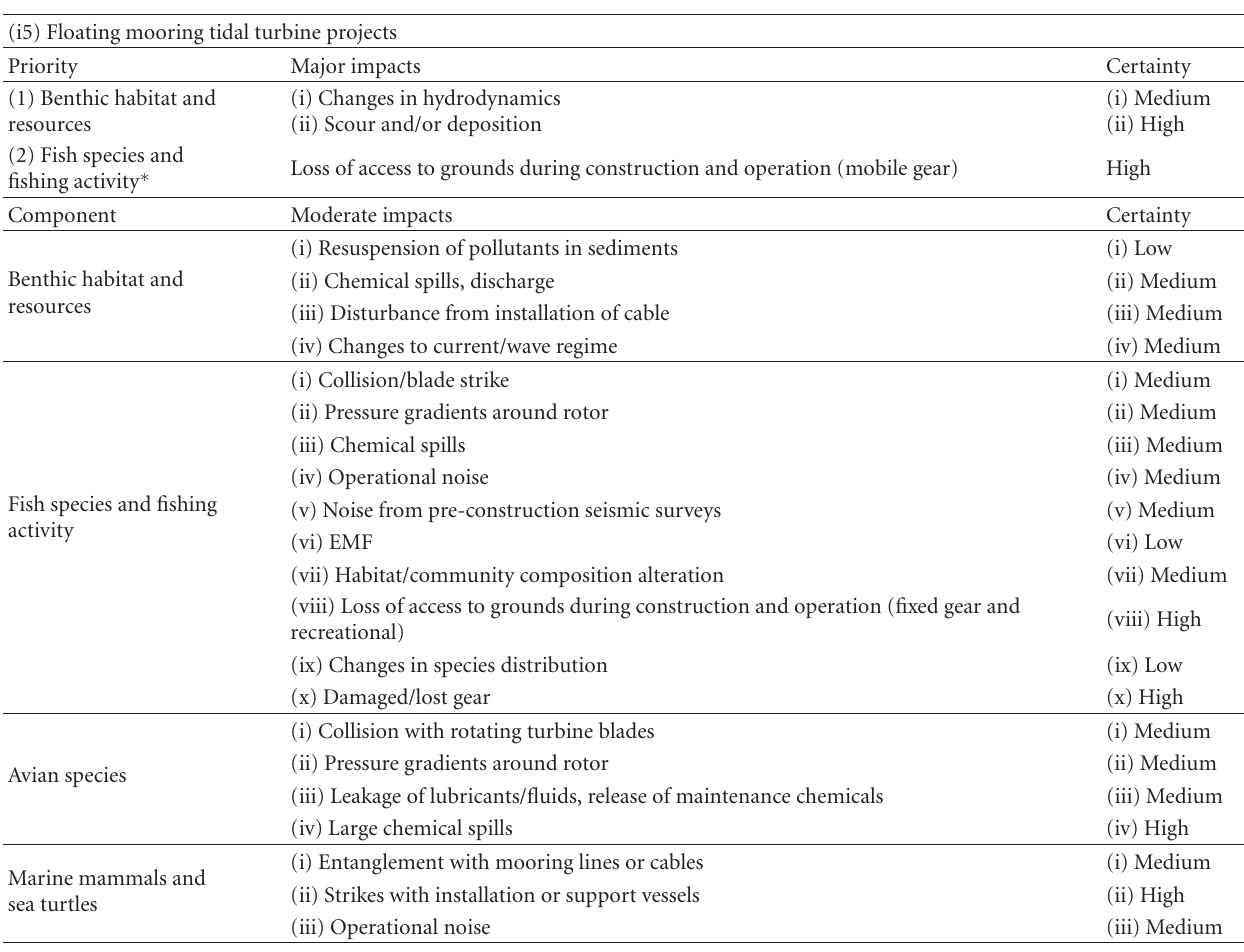
Table 7: A description of the potential impacts resulting from floating mooring tidal turbine projects. See text, Section 3.3, for a narrative summary of this development scenario. Ecosystem components are ranked by their proportion of the major impacts. Moderate impacts are listed in the order they appear in the renewable energy impact